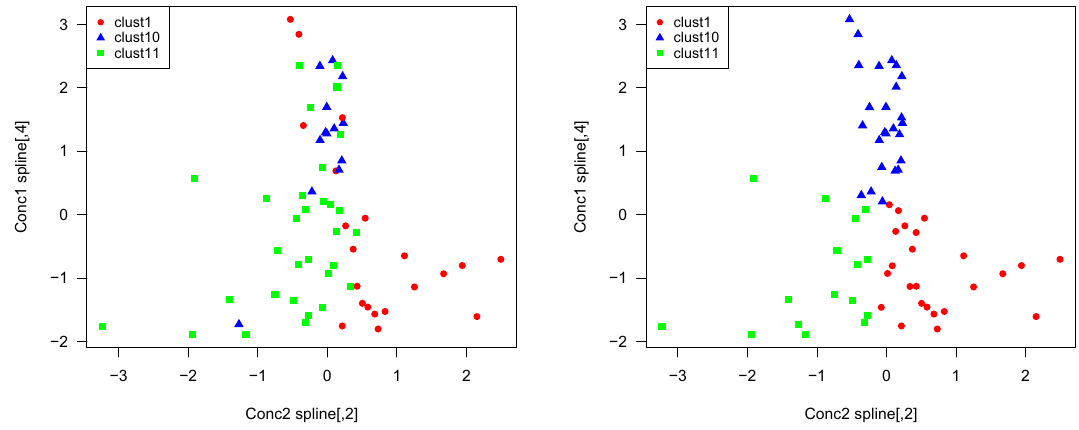
Figure 8. On the left, the true clusters for MOA groups 1, 10, and the remainder. On the right, the results of k-means clustering.